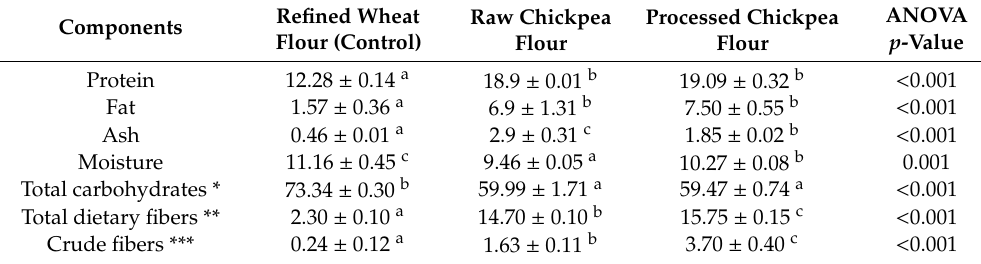
Table 2. Proximate composition of refined wheat flour, as well a raw and processed chickpea flours (%). Refined Wheat Raw Chickpea Processed Chickpea Components Flour (Control) Flour Flour